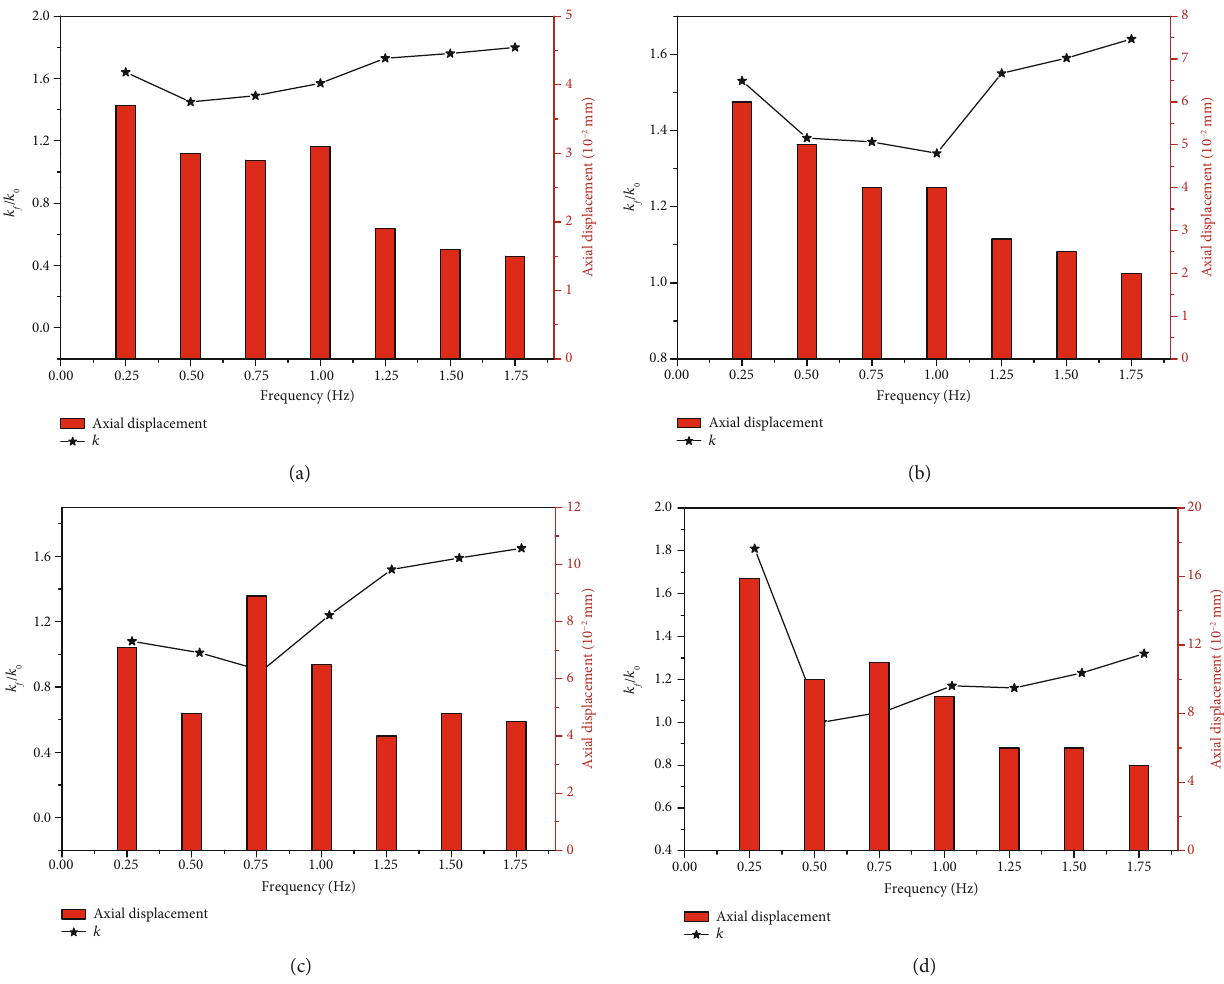
Figure 5: Permeability evolution of fracture and variation of axial displacement under di ff erent frequencies in amplitudes of dynamic axial force of 10 kN, 20kN, 30kN, and 40kN: (a) 10kN in amplitude of dynamic axial force; (b) 20 kN in amplitude of dynamic axial force; (c) 30kN in amplitude of dynamic axial force; (d) 40 kN in amplitude of dynamic axial force. (In these fi gures, the red lines represent axial displacement and the black lines show permeability versus frequency. Permeability after periodic slip ( k f ) normalized by the permeability prior to any cyclic axial forces ( k 0